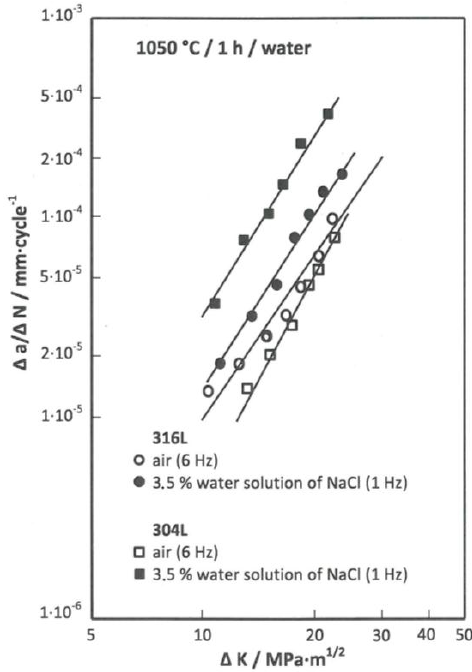
Figure 5. Kinetics of fatigue crack growth for 304L and 316L steels after solution annealing.